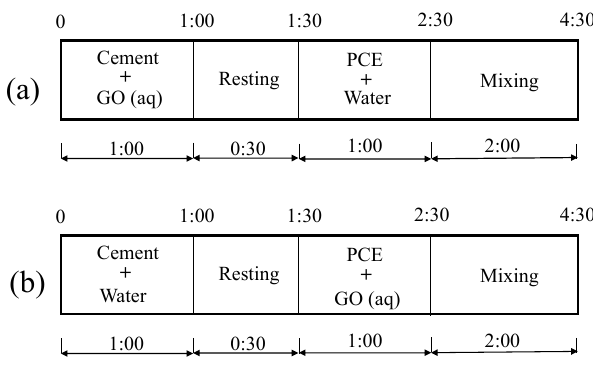
Figure 1. Characterization of graphene oxide (GO) by ( a ) Transmission Electron Microscopy (TEM)